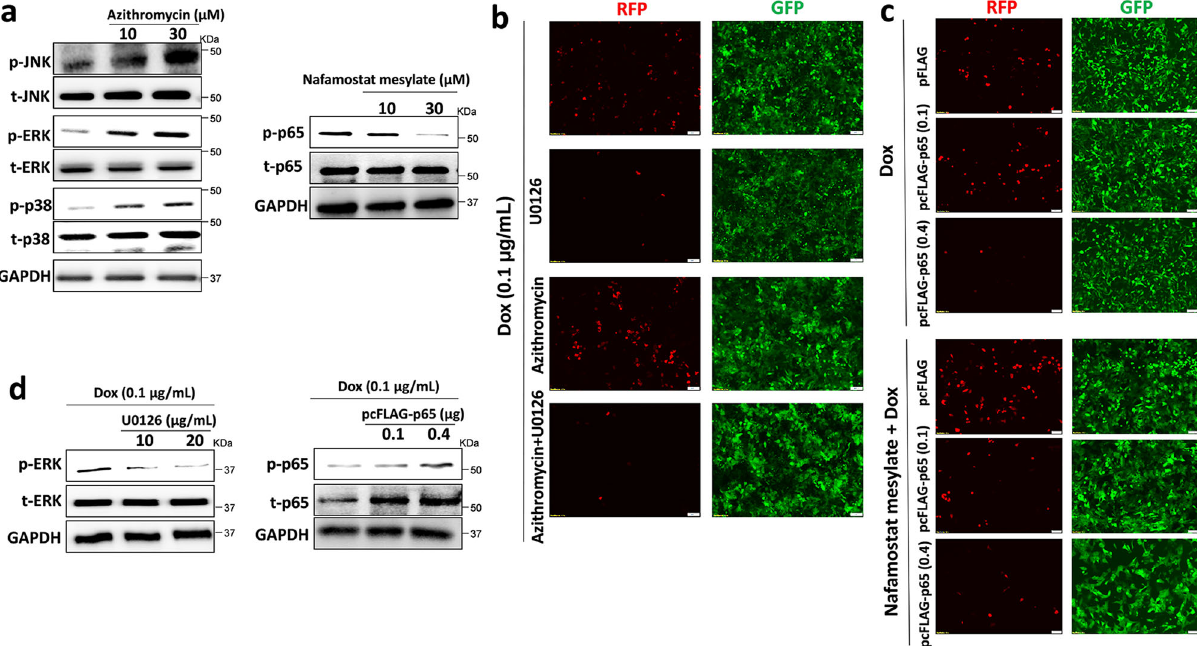
Fig. 4 Cellular mechanisms of Azithromycin and Nafamostat mesylate induced KSHV lytic reactivation. a BCP-1 cells were treated with indicated concentrations of Azithromycin or Nafamostat mesylate for 72h, then protein expression was measured by immunoblots. b The iSLK.219 cells were pre-treated with U0126 (10 μ g/mL), a MAPK kinase inhibitor, for 12h, then addition of Azithromycin together with doxycycline (Dox, 0.1 µ g/mL) induction for 72h. c The iSLK.219 cells were transiently transfected with a construct expressing NF- κ B p65 (pcFLAG-p65 at 0.1 or 0.4 μ g, respectively) or control vector, then addition of Nafamostat mesylate together with Dox induction for 72h. The expression of RFP and GFP was detected using fl uorescence microscopy. d The effects of U0126 and pcFLAG-p65 transfection on signaling activities were con fi rmed by immunoblots. Representative blots from one of two independent experiments were shown. COMMUNICATIONS BIOLOGY| (2021) 4:682 |https://doi.org/10.1038/s42003-021-02220-z|www.nature.com/commsbio